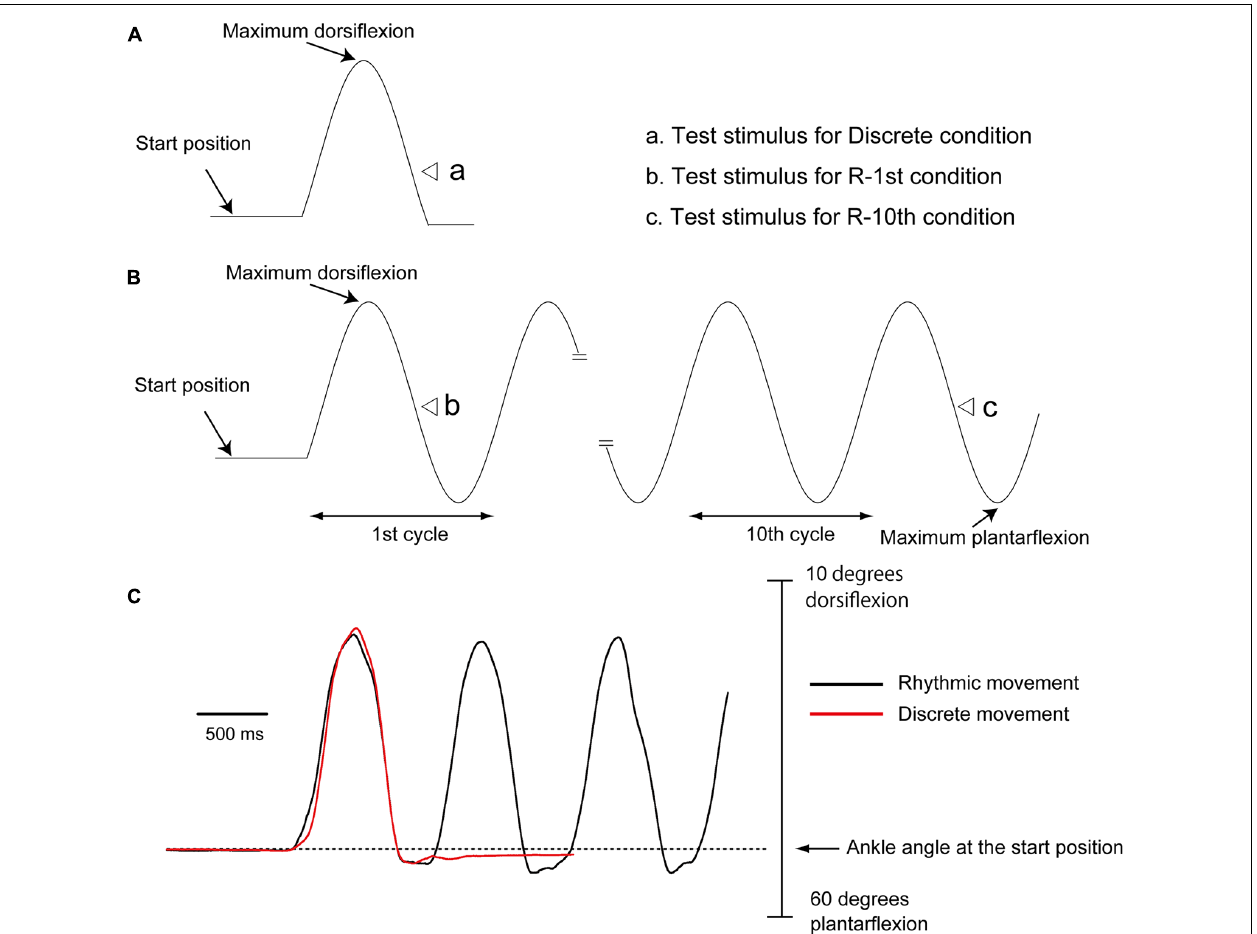
FIGURE 2 |Timing of tibial nerve stimulation or TMS during discrete (A) and rhythmic (B) movements. As shown by the open triangles, tibial nerve stimulation or TMS was delivered when the ankle passed the midline of the plantar flexion phase. Raw traces